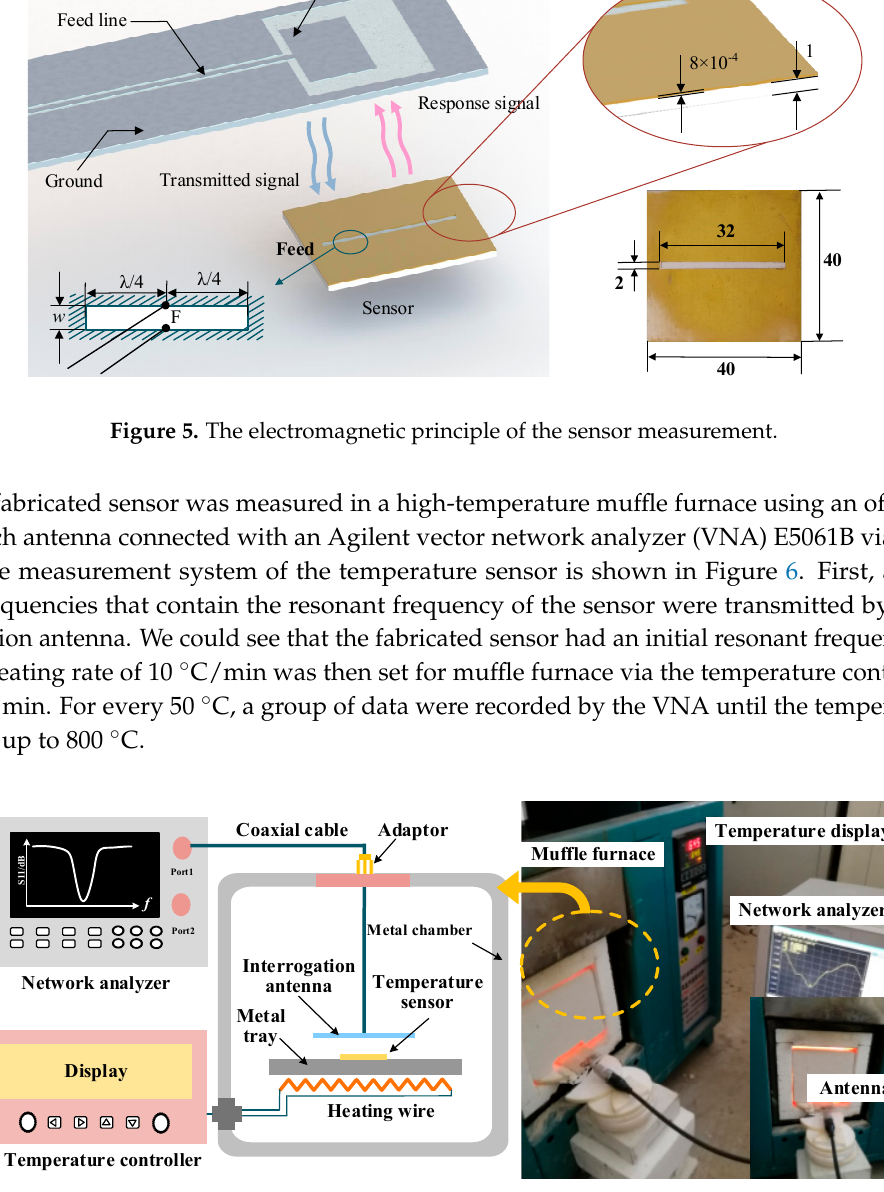
Figure 6. Measurement system of the temperature sensor.